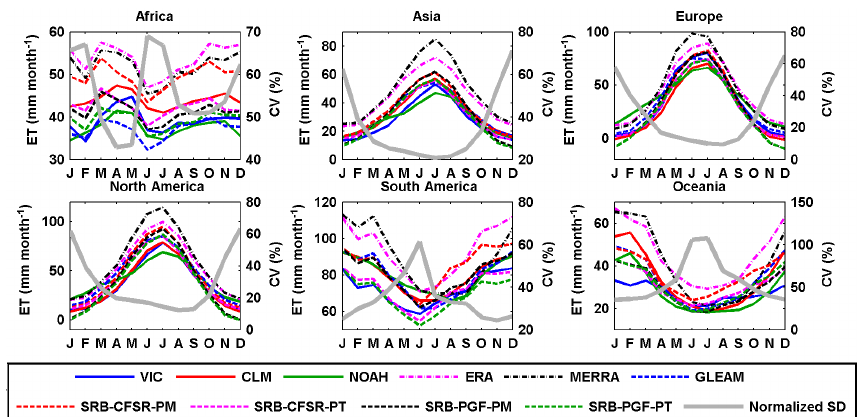
Figure 4. Seasonal cycles of evapotranspiration from different products over the six continents for 1984–2007 (Greenland is excluded for North America, as is true for Figs. 6 and 8).